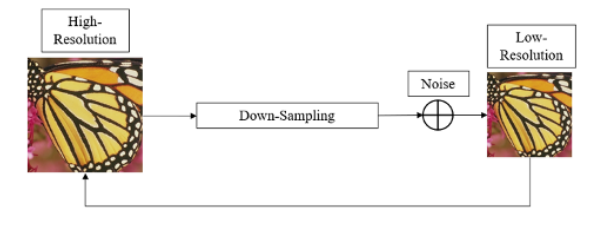
Figure 5. Single image super-resolution